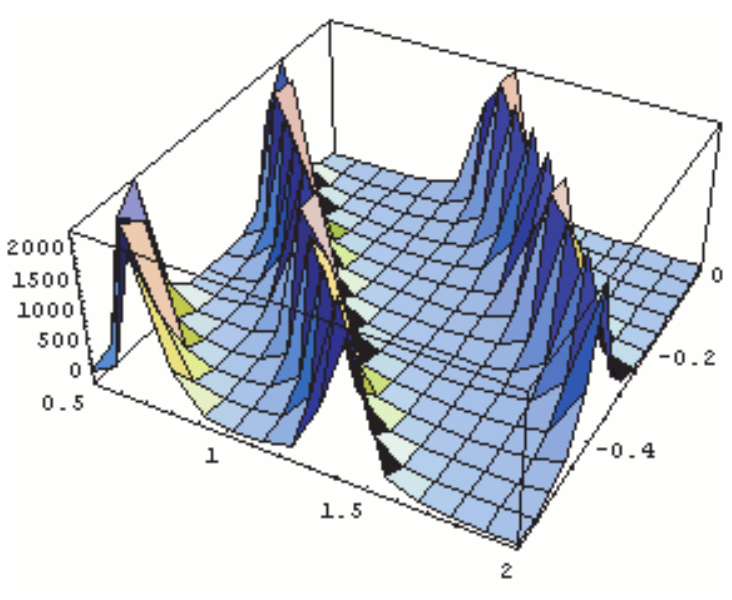
Fig. 7 Solution (66) with k = 0 , C = 10 6 for the Fisher equation